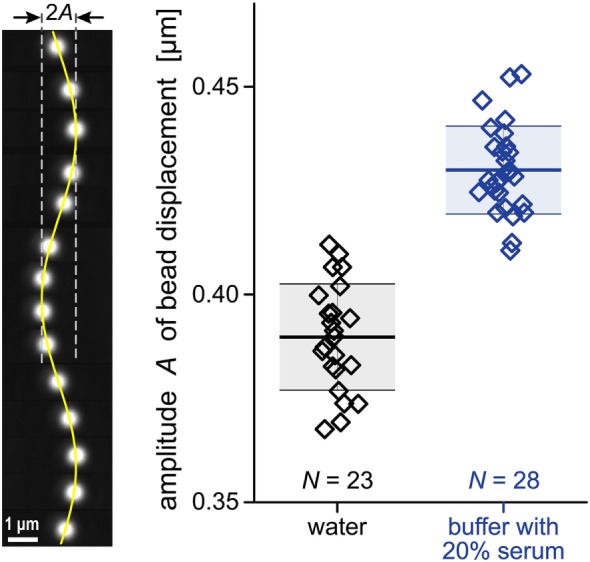
Raw data for our viscosity measurement. A periodic drag force was applied to cause sinusoidal displacements of polystyrene beads (~2.6 μm diameter) trapped by optical tweezers. Our analysis of such bead displacements is illustrated on the left. The vertical filmstrip comprises a sequence of 14 individual bead images taken at ~0.1 s intervals. The composite image includes a graph of a sine function representing the bead position as a function of time. The column-scatter plot on the right shows the amplitudes A of bead displacements measured in two different fluids. The numbers N of individual experiments are given in the plot. Thick horizontal lines mark the average amplitudes for each fluid. They are flanked by thinner lines showing the respective standard deviations. The numerical values of these quantities are given in Eq. 8.